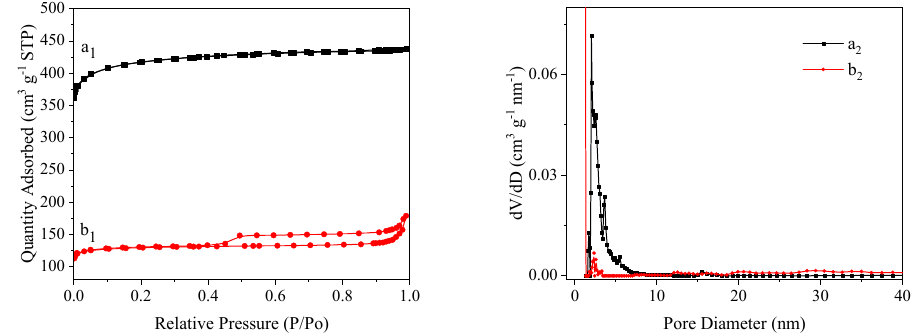
Figure 4. Thermogravimetric analysis of HKUST-1 (black) and TEBAC-HKUST-1 (red).